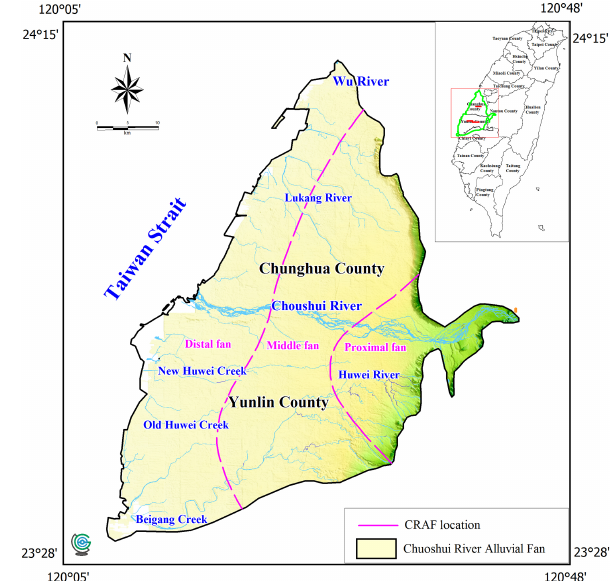
Figure 2. Geological settings of Choshui River Alluvial Fan (modified from Central Geological Survey of Taiwan, http://www. moeacgs.gov.tw/, last access: December